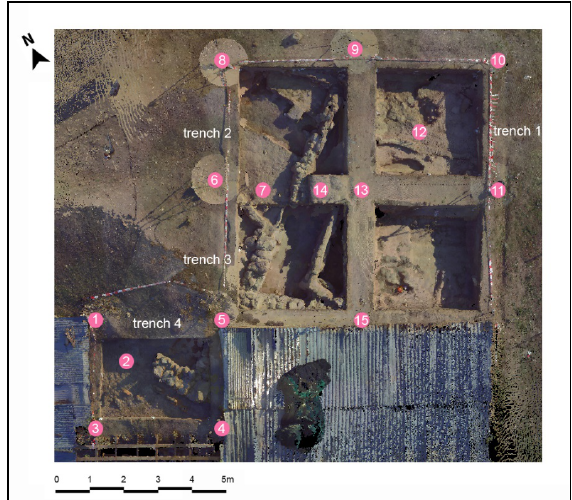
Figure 5 . Τhe positioning of the laser scanner during the second day of the fieldwork (15 measurements).